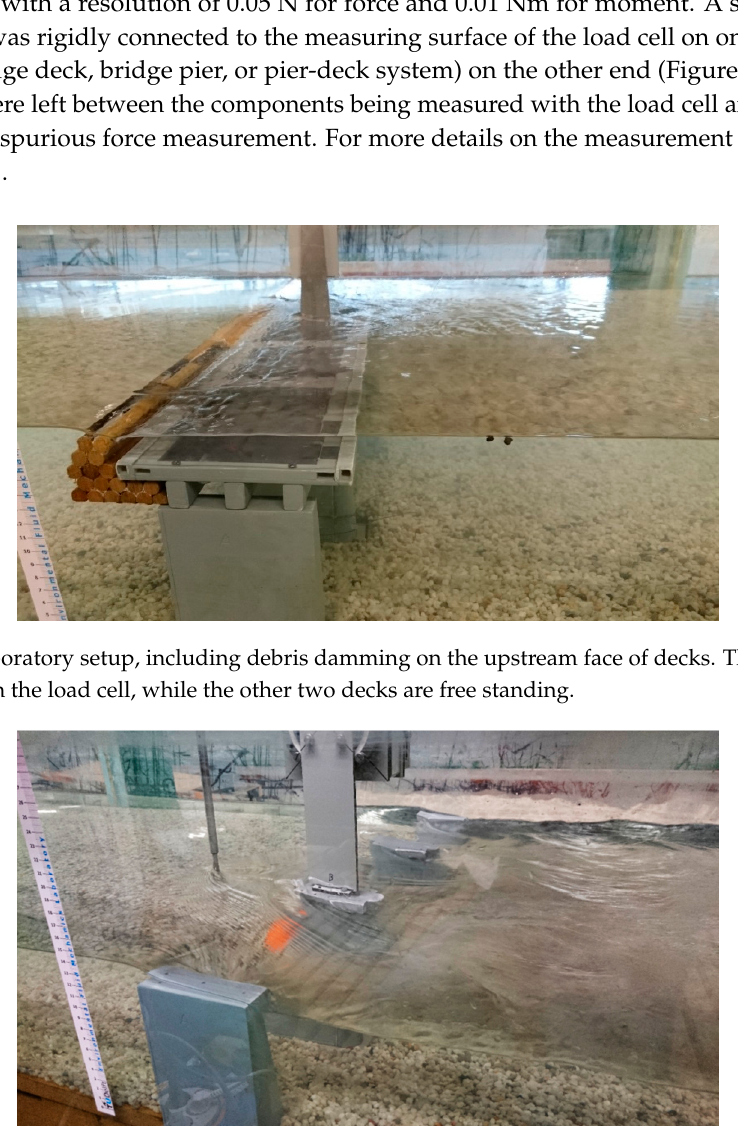
Figure 5. Laboratory setup with one pier connected to the load cell, and the other pier and abutments free standing.